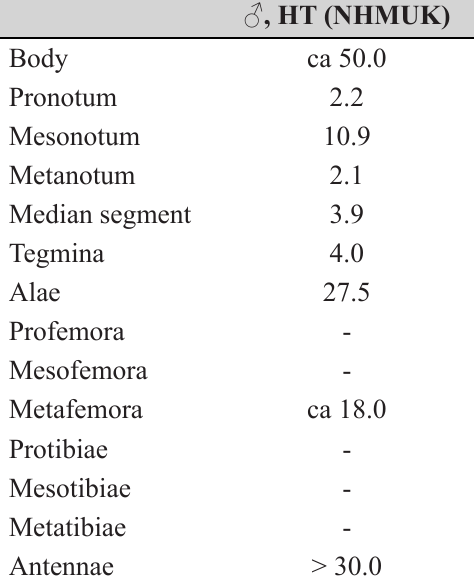
Table 13. Measurements of Phantasca valgius (Westwood, 1859) (in mm). HT =